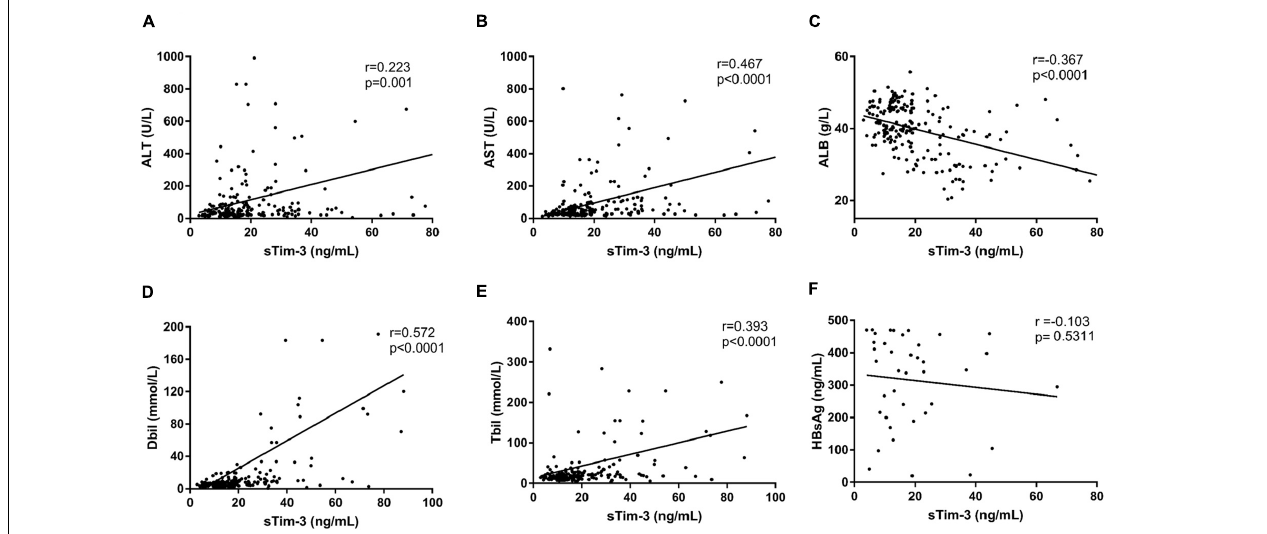
FIGURE 2 | Relationship between sTim-3 levels and liver function indexes in patients with hepatitis virus infection. (A) Correlation analysis of sTim-3 and ALT levels showed a significant positive correlation. (B) Correlation analysis of sTim-3 and AST levels showed a significant positive correlation. (C) Correlation analysis of sTim-3 and ALB levels showed a significant negative correlation. (D) Correlation analysis of sTim-3 and Dbil levels showed a significant positive correlation. (E) Correlation analysis of sTim-3 and Tbil levels showed a significant positive correlation. (F) Correlation analysis of sTim-3 and HbsAg levels was not significant.